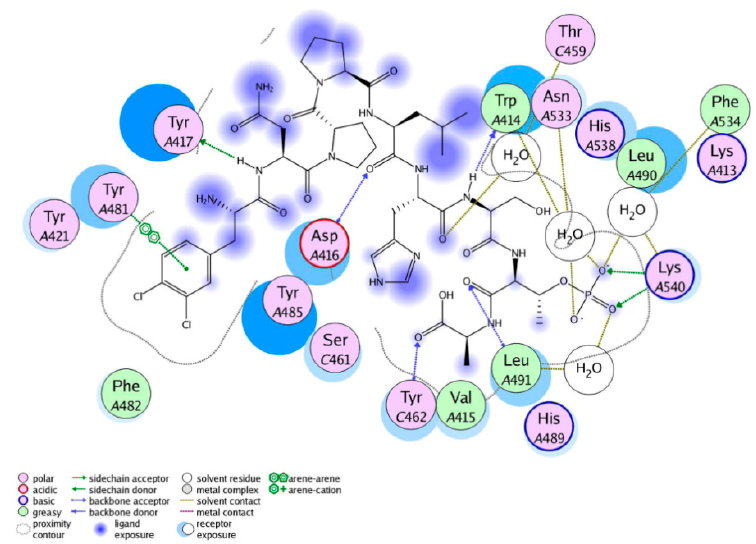
Figure 4. The ligand–protein interaction diagram for the binding site of PLK1-PBD (PDB ID: 3Q1I) with peptide 5. The active site residues are represented as follows: Polar residues in light purple, hydrophobic residues in green, acidic residues with a red contour ring, basic residues with a blue contour ring. Green and blue arrows indicate hydrogen bonding to side chain and backbone atoms respectively. The π – π stacking interactions are represented as green dotted lines. Light-blue “halos” around residues indicate the degree of interaction with ligand atoms (larger and darker halos means more interaction).